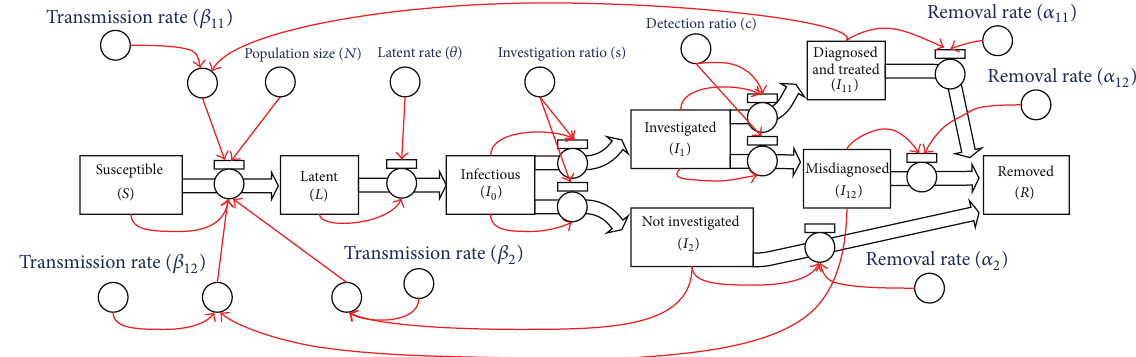
Figure 4: System dynamics flowchart: modified SLIR compartmental model in layer 1 of the FLUed